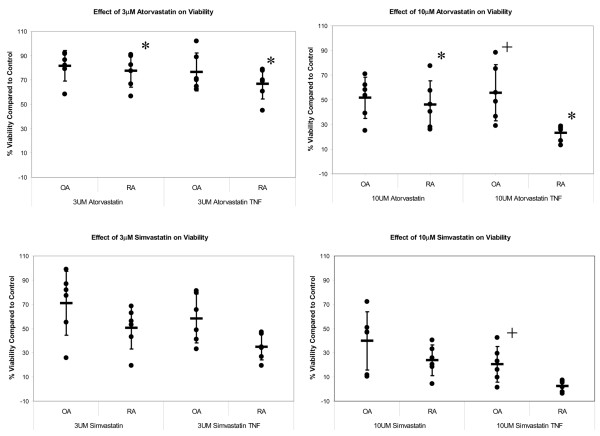
Statins are most effective at inhibiting the viability of TNF-α-stimulated RA synovial fibroblasts. Synovial fibroblasts derived from patients with rheumatoid arthritis (RA) (n = 6) and osteoarthritis (OA; n = 6) were stimulated or not with 10 ng/ml tumor necrosis factor-α (TNF-α) for 24 hours before the addition of 3 or 10 μM atorvastatin or simvastatin. They were then maintained for a further 96 hours in the presence or absence of TNF-α and statin. XTT assays were performed on quadruplicate wells. The percentage cellular viability was determined by comparing statin-treated cultures with non-treated cultures in either the presence or absence of TNF-α as appropriate. Means and standard deviations are indicated by solid bars. *p < 0.05 for atorvastatin-treated versus simvastatin-treated RA fibroblasts. +p < 0.05 for RA versus OA TNF-α-stimulated fibroblasts.